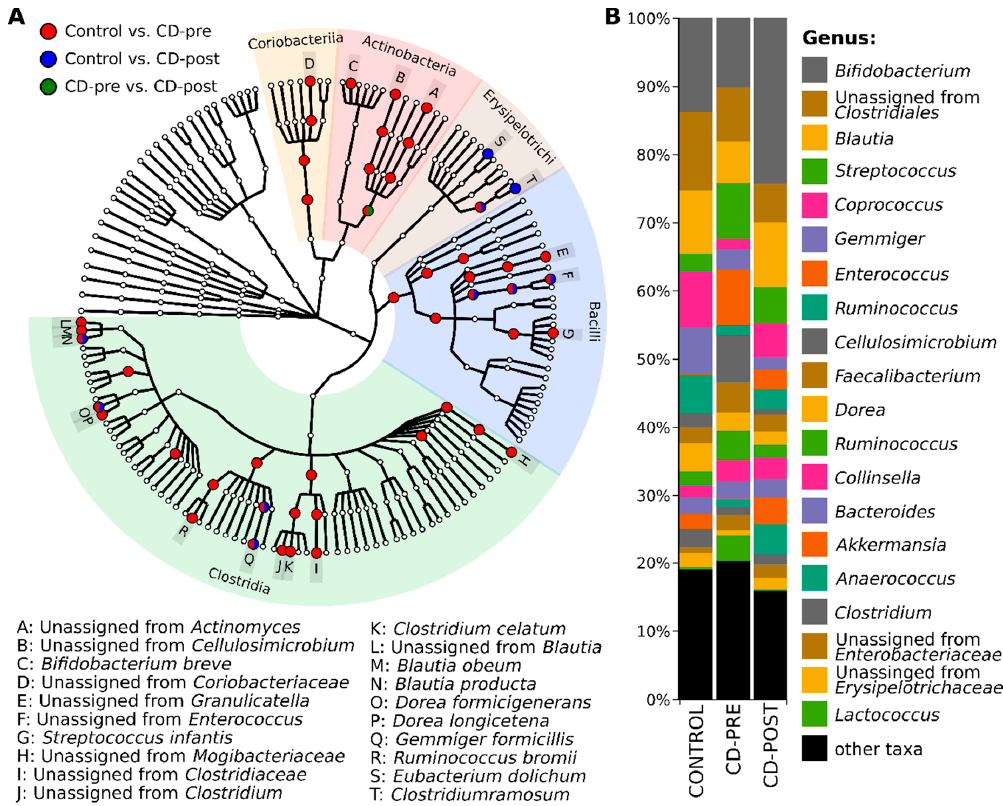
Figure 5. Taxa that differ significantly between control and patients with CD pre- and post-IFX therapy ( A ), and a bar plot representing the relative abundance of top 20 genera ( B ).